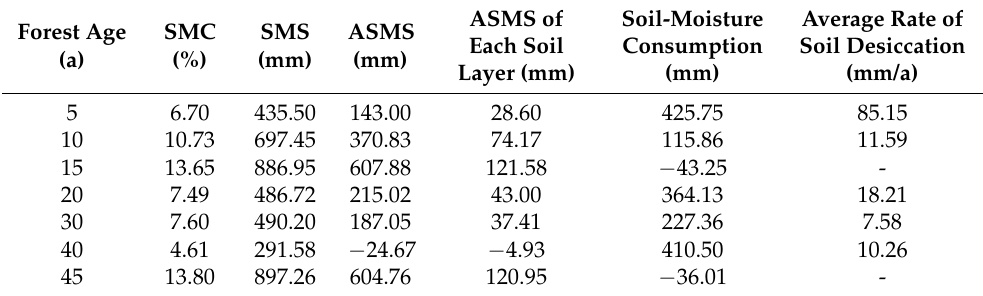
Table 4. Comparison of soil-moisture content under different-aged R. pseudoacacia on Chinese Loess